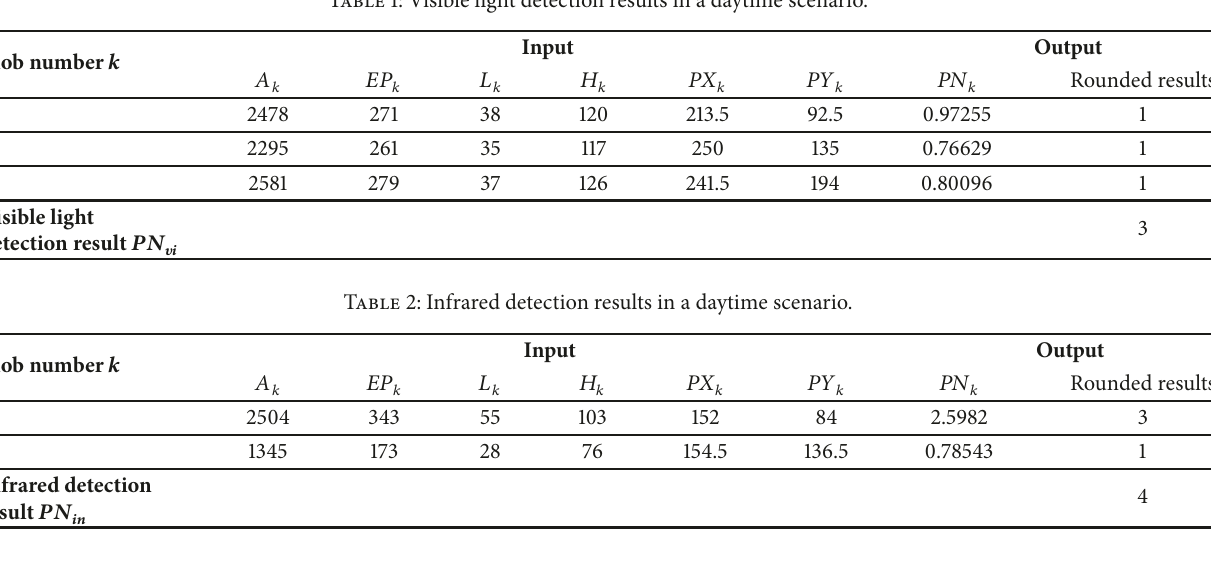
Table 1: Visible light detection results in a daytime scenario.